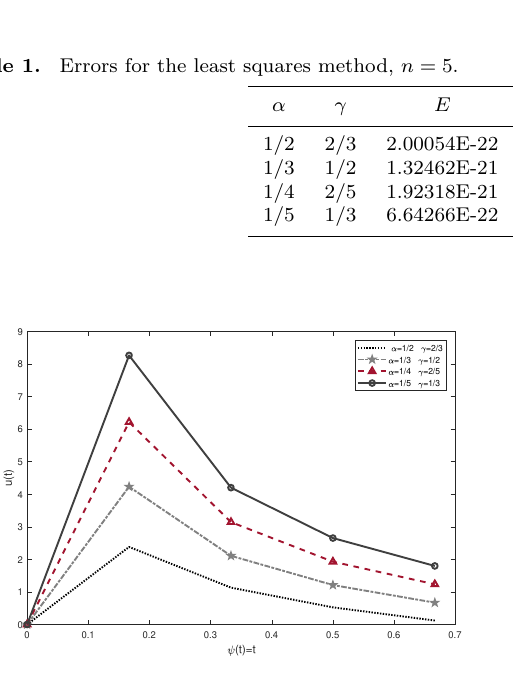
Figure 1. Solution of illustrated example with some values of α , γ and n =